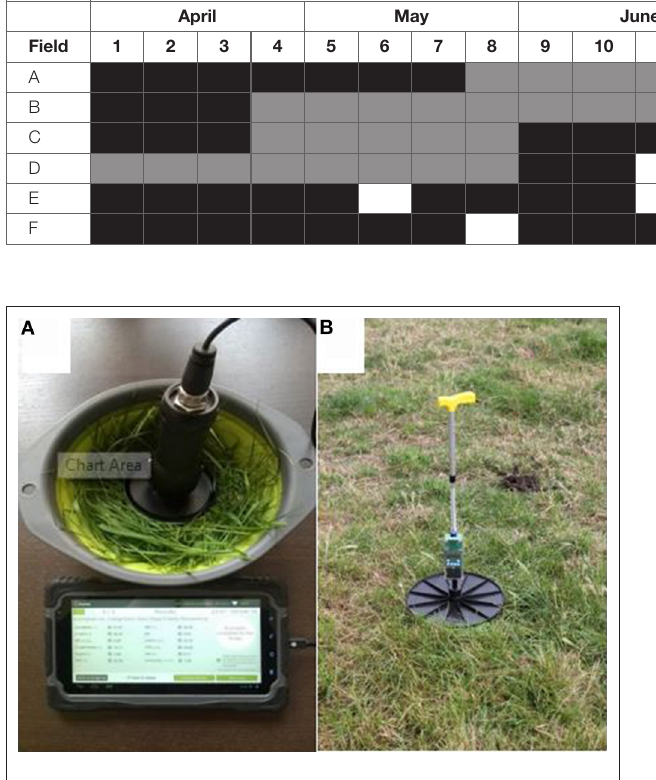
FIGURE 2 | Pasture measurement devices of (A) Tablet near-infrared spectroscopy scanner and tablet for nutrient analysis and (B) rising plate meter for herbage